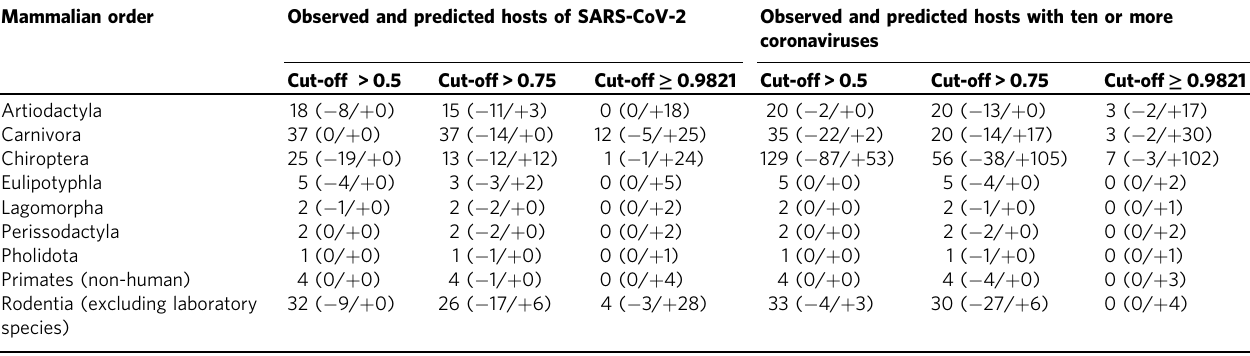
Table 1 Observed and predicted number of hosts of SARS-CoV-2 (by mammalian order), and observed and predicted number of hosts with ten or more coronaviruses (from our set of 411 species or strains). Mammalian order Observed and predicted hosts of SARS-CoV-2 Observed and predicted hosts with ten or more